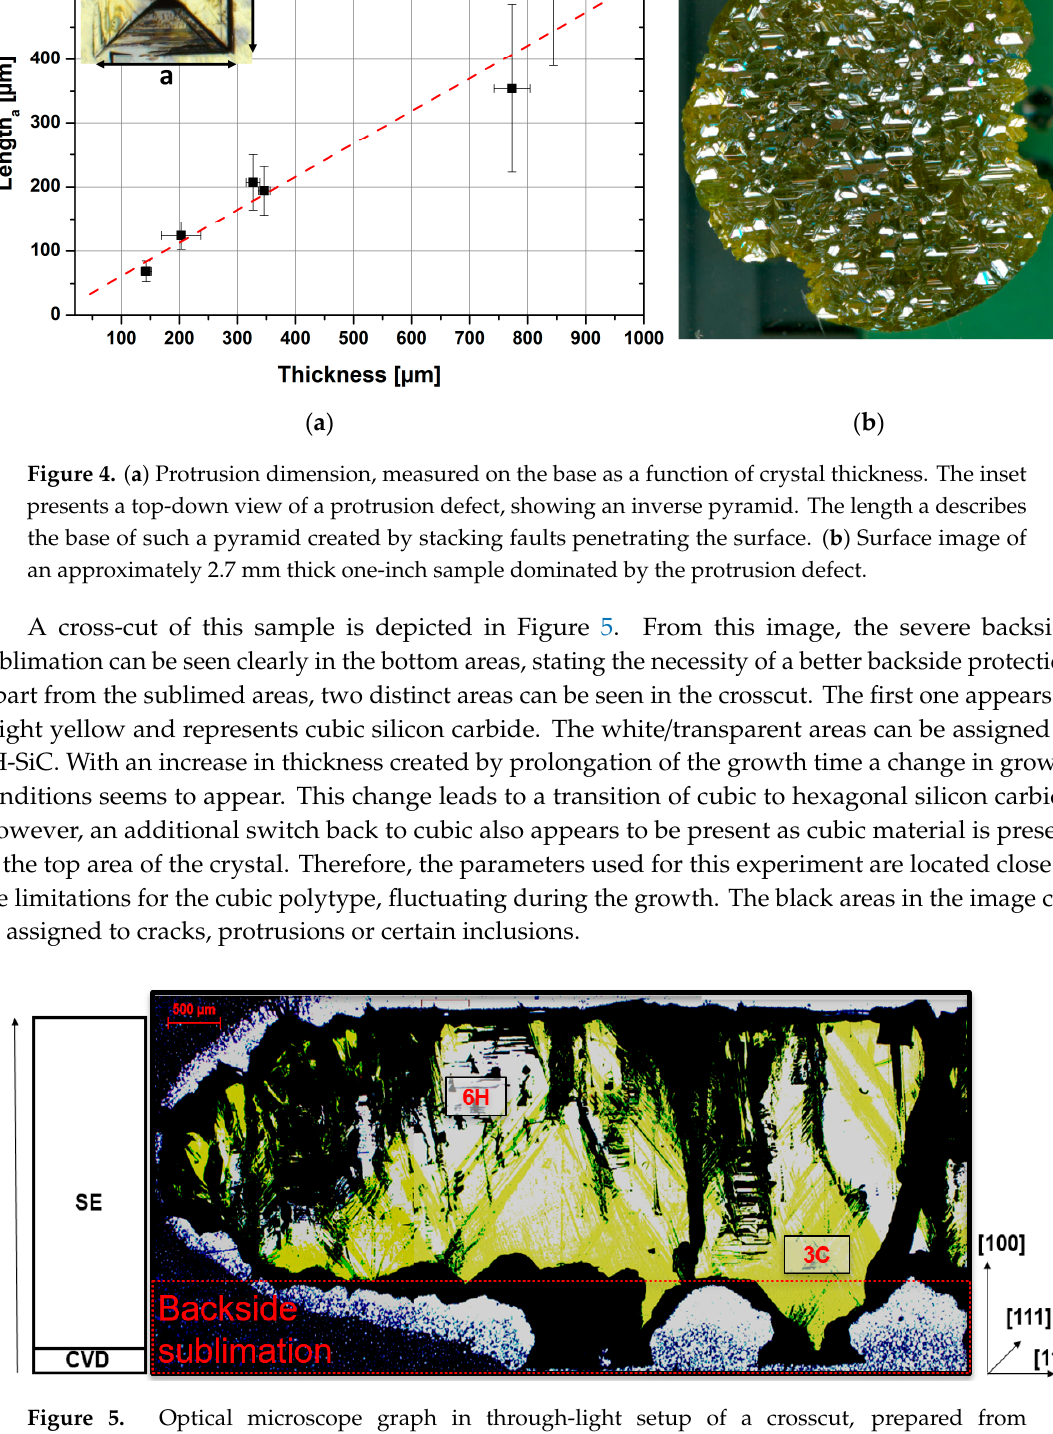
Figure 5. Optical microscope graph in through-light setup of a crosscut, prepared from an approximately 2.7 mm thick one-inch sample. Yellow areas represent cubic silicon carbide. White (transparent) areas describe hexagonal inclusions. Etched areas located at the bottom resemble backside sublimation during the growth. backside sublimation during the